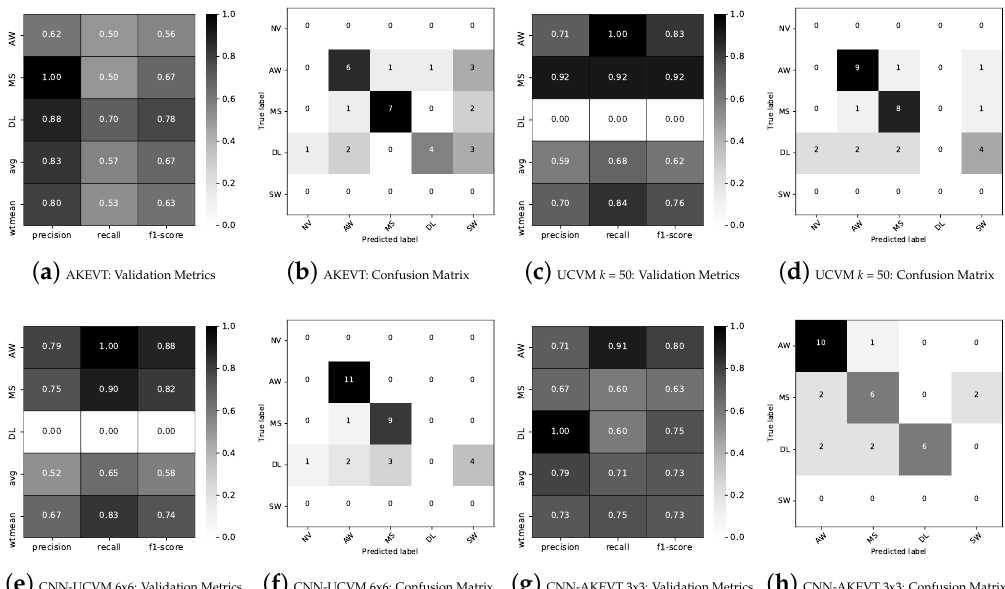
Figure 13. Validation statistics using field vegetation observations in the Kougarok watershed for ( a ) AKEVT, ( b ) UCVM, ( c ) CNN-UCVM (6 × 6), ( d ) CNN-AKEVT (3 × 3). (AW: Alder-Willow Shrub; DL: Dryas/Lichen Dwarf Shrub Tundra; MS: Mixed Shrub-Sedge Tussock Tundra-Bog; NV: Non-Vegetated; SW: Sedge-Willow-Dryas Tundra, and W: Water. avg: average score; wtmean: area weighted mean